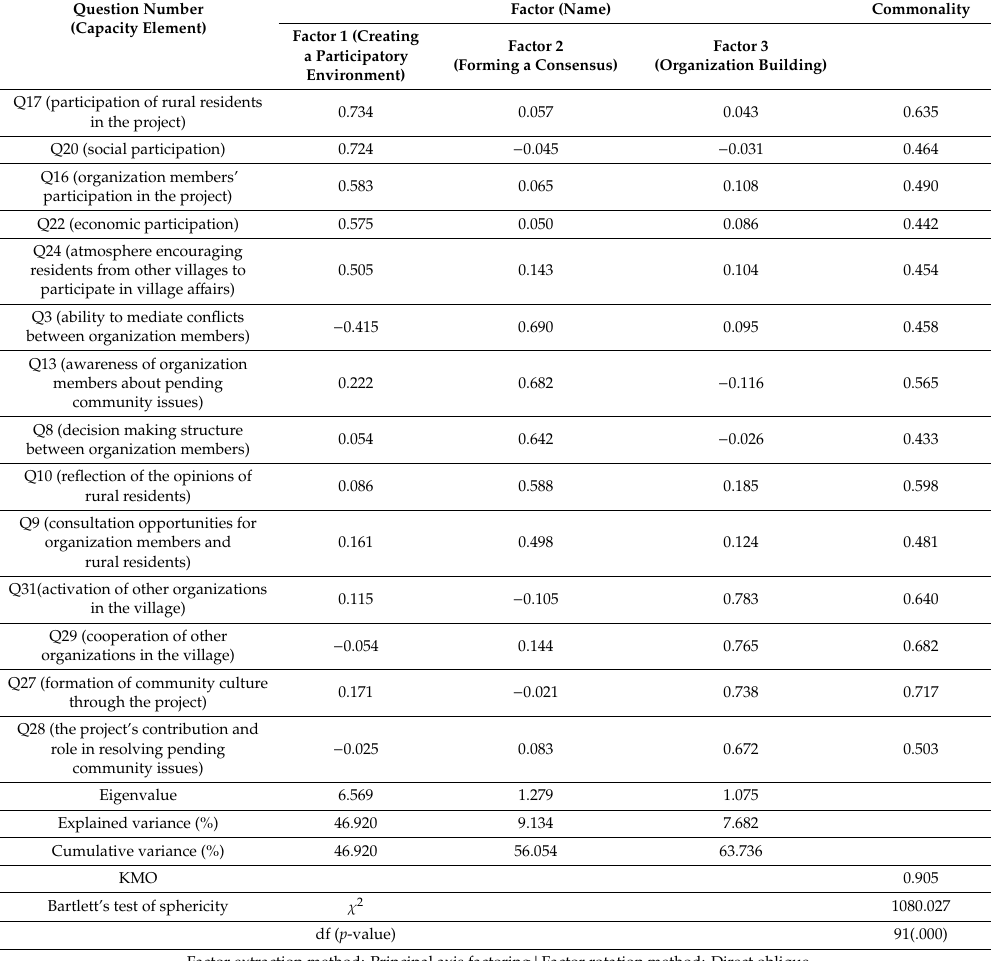
Table 3. The results of verifying the validity of the preliminary component